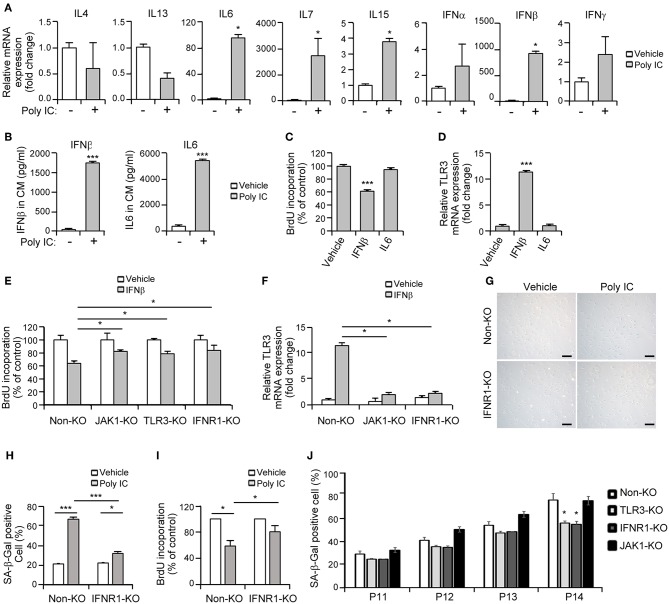
Interferon-β (IFN-β) is a crucial component of senescent-associated secretory phenotype (SASP) in TLR3-dependent MSC senescence. (A) mRNA expression levels of the indicated cytokines in poly IC stimulated-MSCs after 24 h were determined using qPCR. (B) The secreted protein levels of IFN-β and IL-6 in MSC conditioned media after poly IC treatment for 48 h were measured using ELISA. (C) Analysis of cell growth in MSCs treated with IFN-β (100 ng/ml) and IL-6 (100 ng/ml) for 48 h. (D) mRNA expression of TLR3 after treatment of MSCs with IFN-β and IL-6, as determined by qPCR. (E,F) Cell proliferation (E) and relative TLR3 mRNA expression (F) following INF-β treatment were measured in control, JAK1-knockout (KO), TLR3-KO, and interferon alpha and beta receptor subunit 1 (IFNAR1)-KO MSCs. The transcript levels were normalized to those of GAPDH. (G) Control and IFNAR1-knockout MSCs were stimulated with 1 μg/ml poly IC for 48 h and stained with SA-ß-gal. Scale bars, 20 μm. (H) The percentage of SA-ß-gal positive cells was determined. (I) Cell proliferation was measured by BrdU incorporation. (J) Non-KO, TLR3-KO, IFNAR1-KO, and JAK1-KO MSCs at passage 11–14 were stained with SA-ß-gal and the percentage of SA-ß-gal positive cells was determined. All data were obtained from three independent experiments. The values are the mean ± SEM (n = 3). *P < 0.05; ***P < 0.001. P values were calculated using the Mann-Whitney test (A) or Kruskal-Wallis test (B–J).